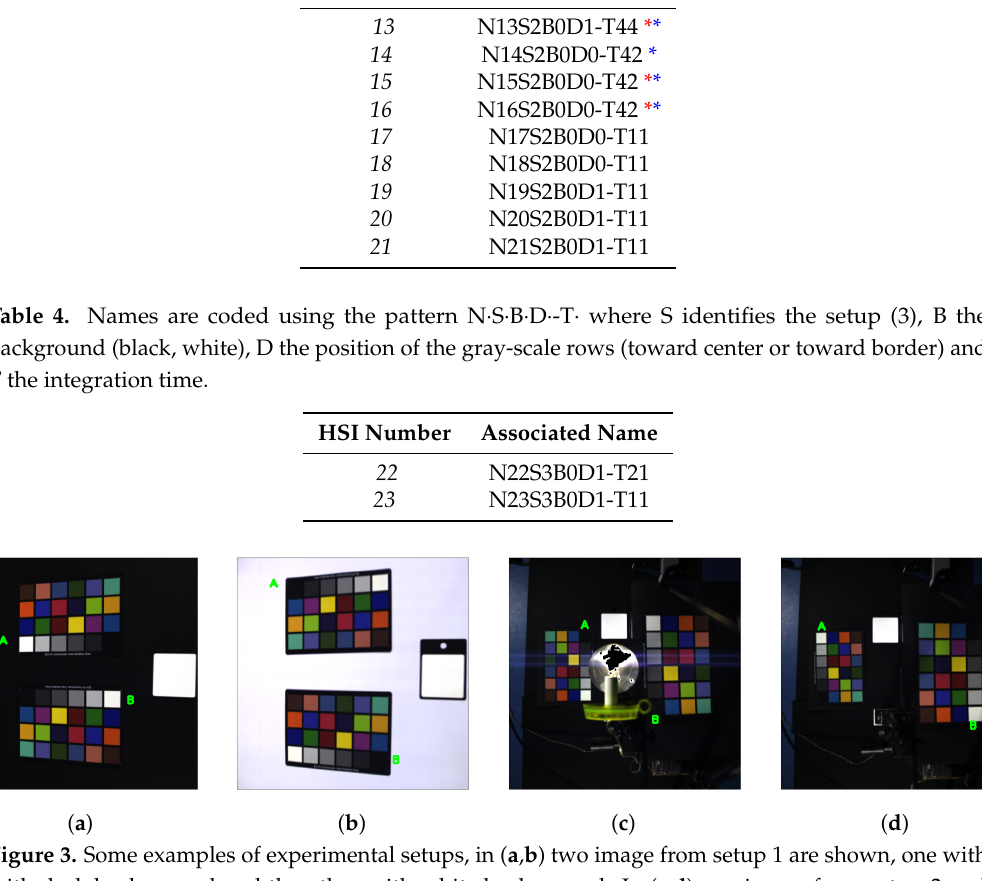
Figure 3. Some examples of experimental setups, in ( a , b ) two image from setup 1 are shown, one with with dark background and the other with white background. In ( c , d ) one image from setup 2 and another from setup 3 are